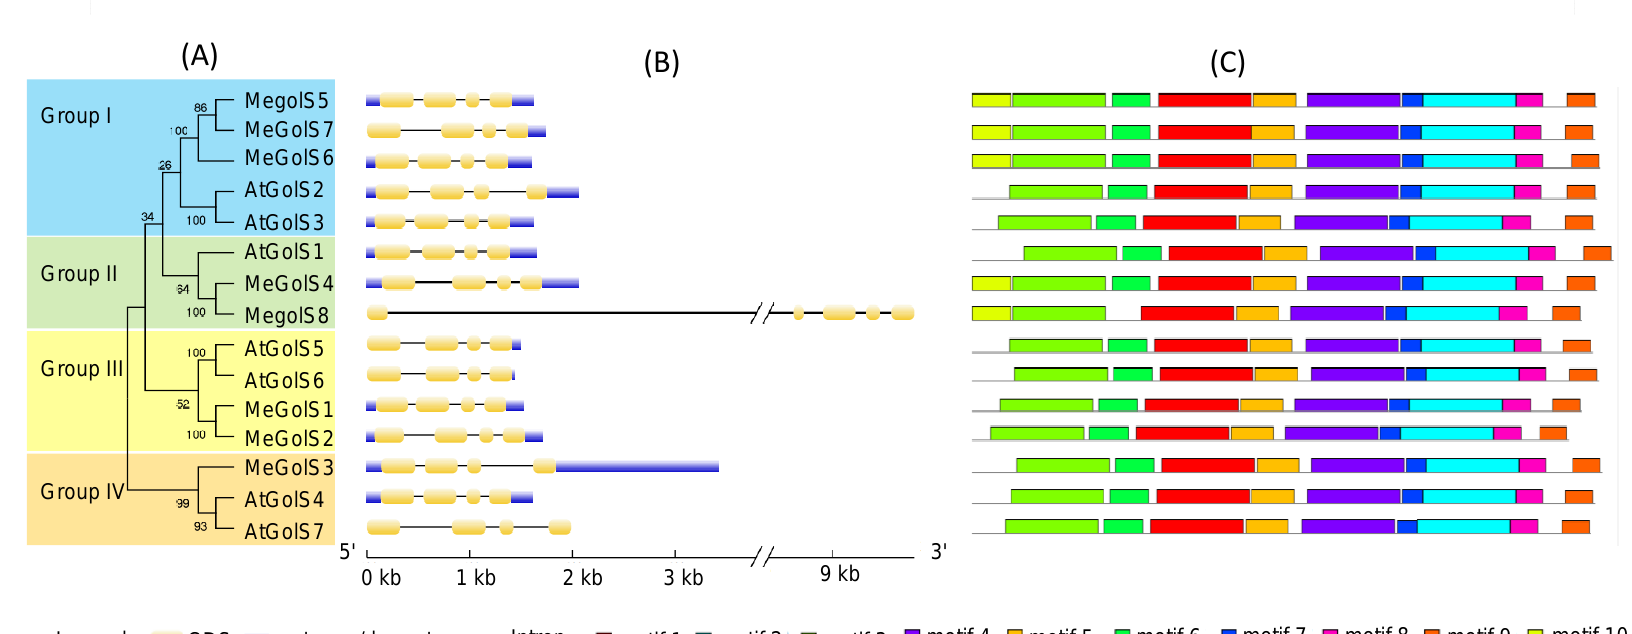
Figure 2. Comparative analysis of the phylogenetics, structure, and conserved motifs of GolSs from cassava and Arabidopsis . ( A ) The phylogenetic tree of MeGolSs and AtGolSs was constructed by using MEGA 7.0 and all the GolSs were classed into four groups. ( B ) GSDS software was employed to generate the gene structures of MeGolSs and AtGolSs. The yellow boxes are CDS, the blue boxes are 5′UTR or 3′UTR, and the black lines are introns. ( C ) Conserved motifs of MeGolSs and AtGolSs proteins from cassava and Arabidopsis . The gene order in B and C is similar to A.